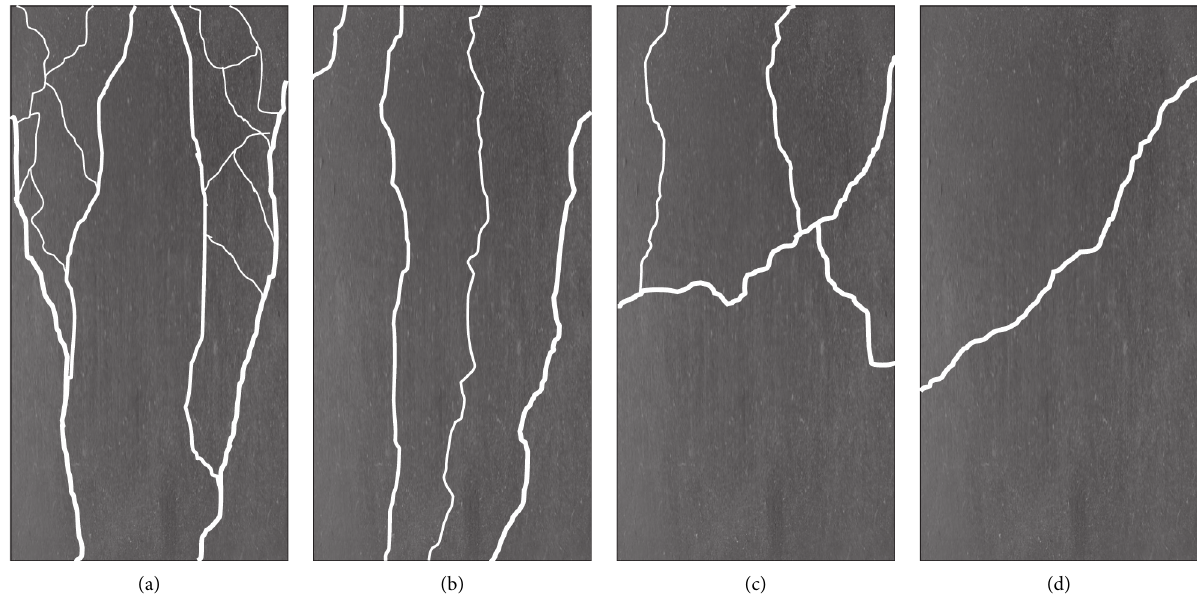
Figure 9: Failure modes of samples under different loading rates: (a) the loading rate is 5 × 10 − 7 m/s; (b) the loading rate is 5 × 10 − 6 m/s; (c) the loading rate is 1.7 × 10 − 5 m/s; (d) the loading rate is 5 × 10 − 5 m/s.